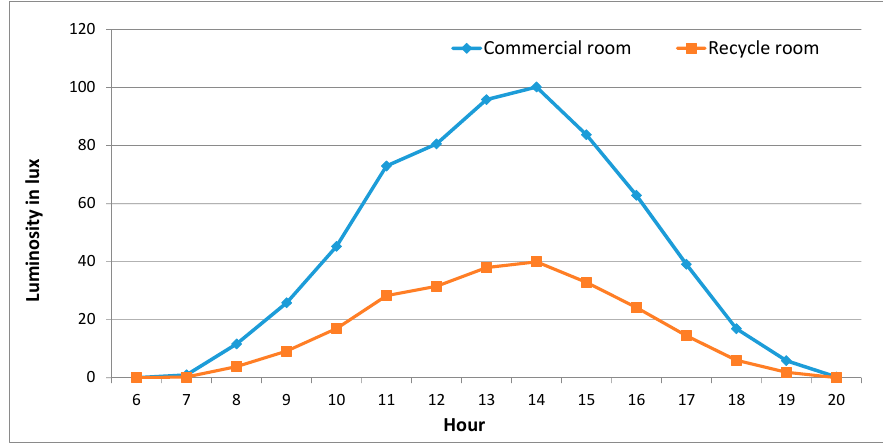
Figure 8. Luminosity expected for the test environments in 2016, from 06:00 to 20:00 h.